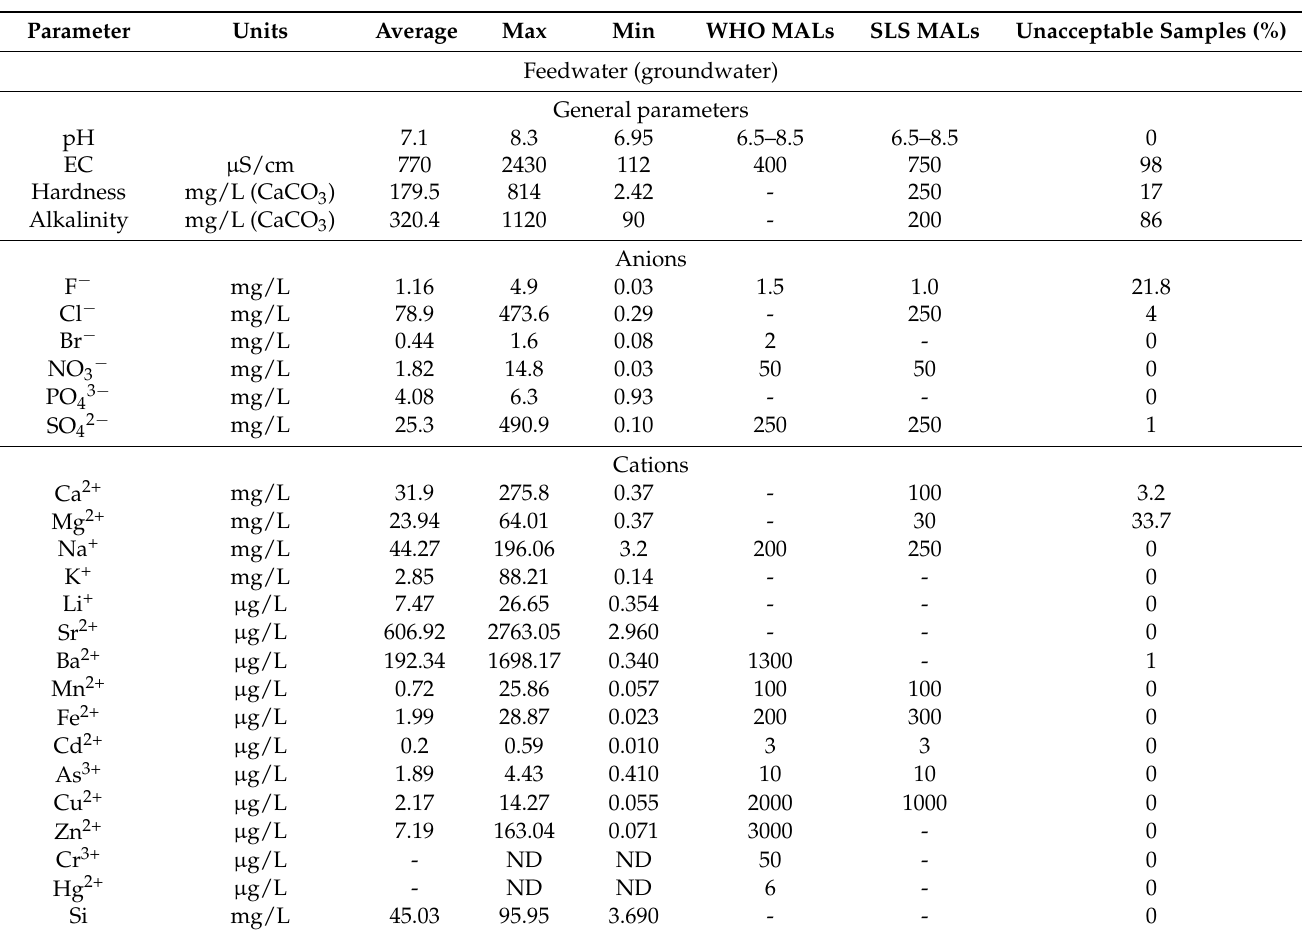
Table 1. Feedwater (groundwater) quality of stations in NCP with the comparison of drinking water quality standards (WHO and SLS).